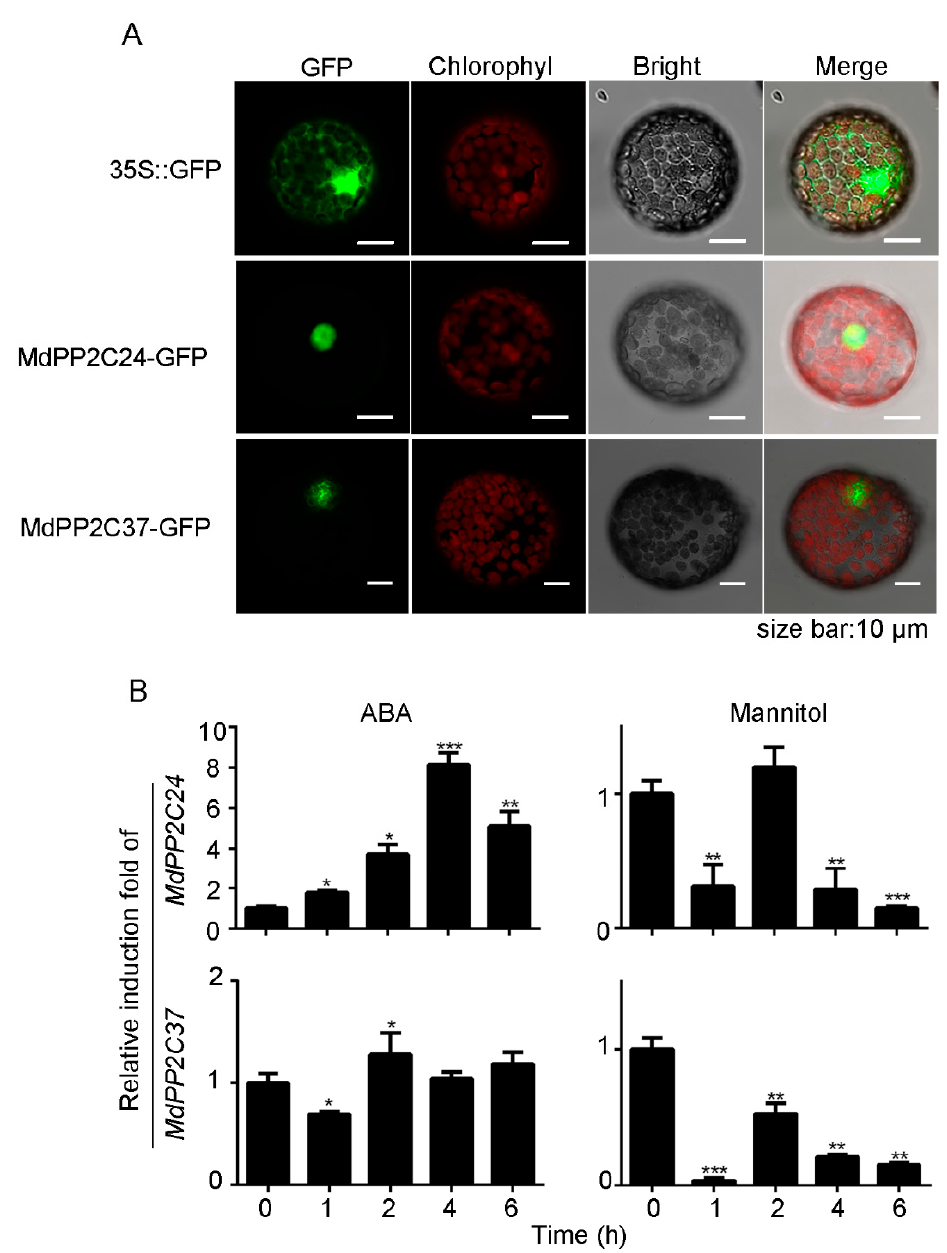
Figure 2. Nucleus-located genes MdPP2C24/37 were induced by ABA or mannitol. ( A ) Subcellular localization of MdPP2C24/37-GFP fusion proteins in tobacco protoplasts. 35S ::GFP alone or MdPP2C24/37-GFP correspond to chlorophyll and bright field images, respectively, and the su- perposition of fluorescent illumination, chlorophyll, and bright field images is shown. ( B ) Real-time qPCR analysis of MdPP2C24/37 expression in apple leaves. Total RNA was isolated from the ABA- or mannitol-treated apple leaves and used for real-time qPCR. Results represent mean ± SE from three independent experiments, with similar results obtained. Values were significantly different from WT at * p < 0.05, ** p < 0.01 or *** p <